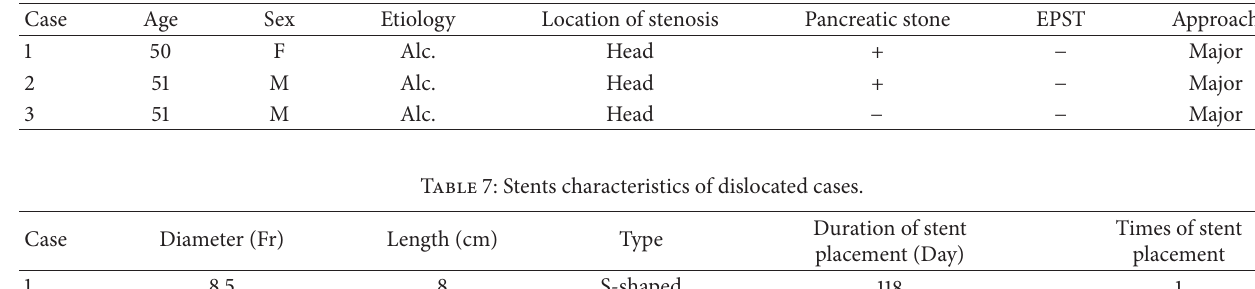
Table 6: Patients characteristics of dislocated cases.